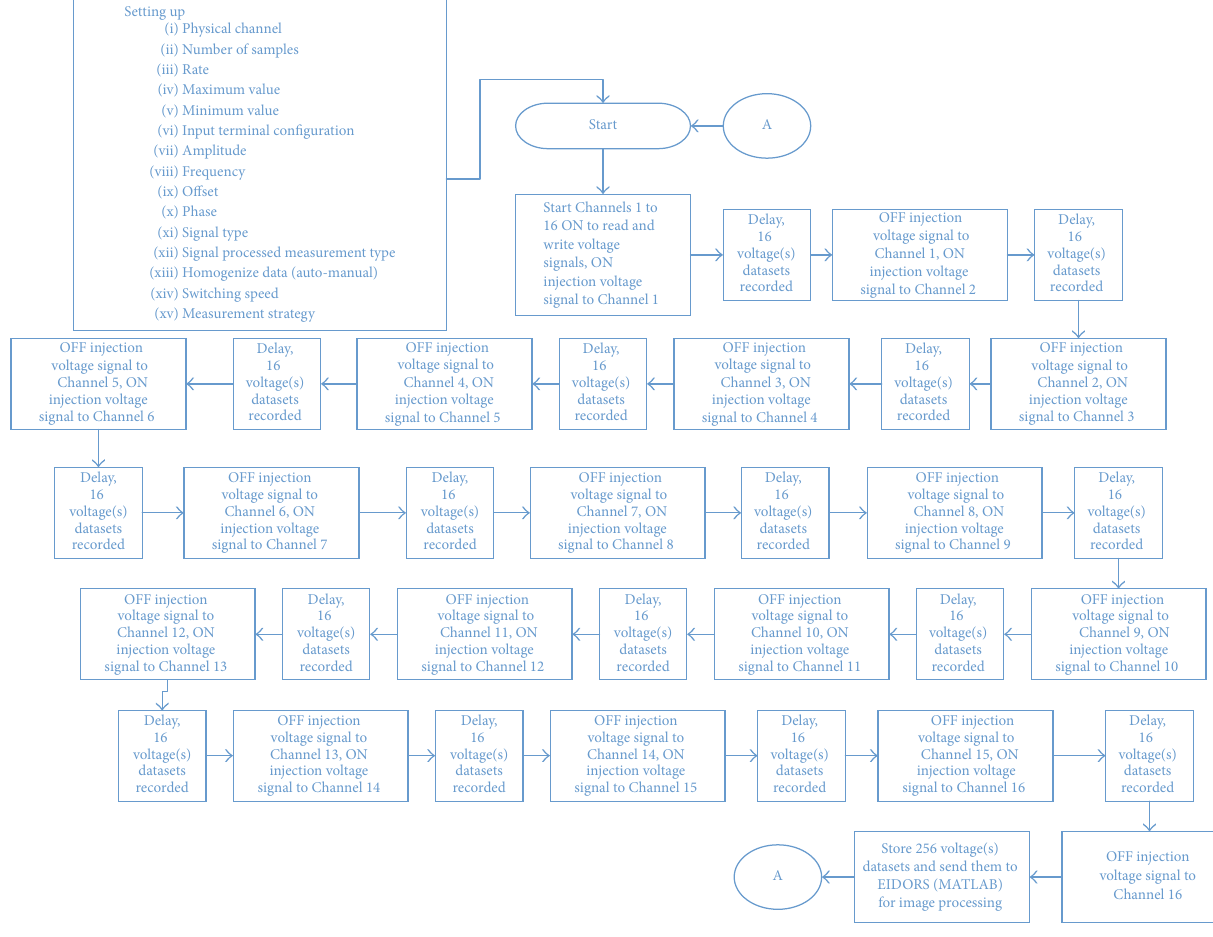
Figure 2: Flowchart of the stages of the process for the programmable EIT system.